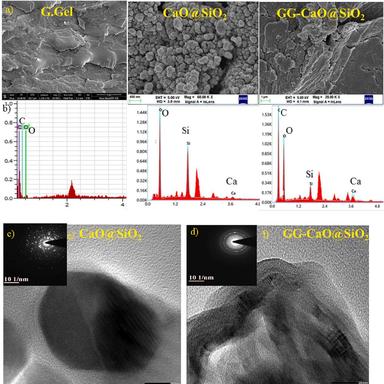
(a) FE-SEM (b) EDS of guar gum gel (GG), CaO@SiO2 and GG- CaO@SiO2 (c,d) SAED pattern (e,f) HR-TEM images of CaO@SiO2 and GG- CaO@SiO2 nanocomposite.